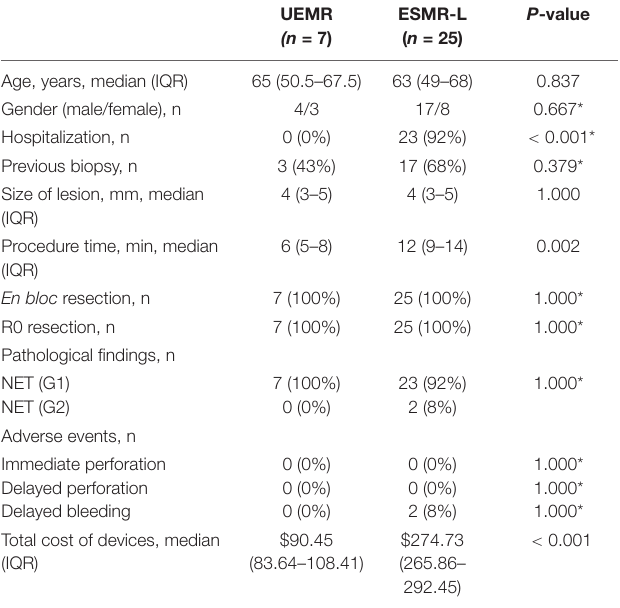
TABLE 2 | Comparison of characteristics and outcomes of underwater endoscopic mucosal resection without submucosal injection (UEMR) and endoscopic submucosal resection with a ligation device (ESMR-L).